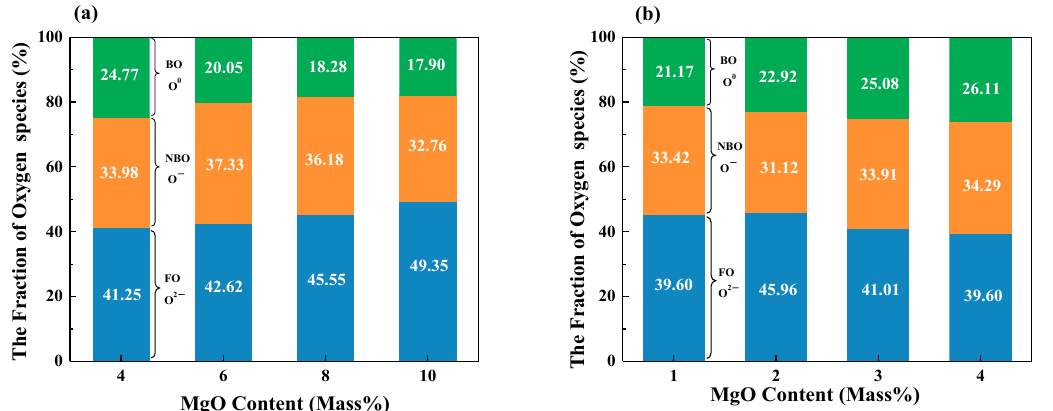
Figure 8. The O 1s XPS spectra for SiO 2 –CaO–25 mass% Al 2 O 3 –8 mass% MgO–MnO–K 2 O slag as function of binding energy ( a ) with varying MgO content; ( b ) with varying K 2 O content; BO is Bridging oxygen.